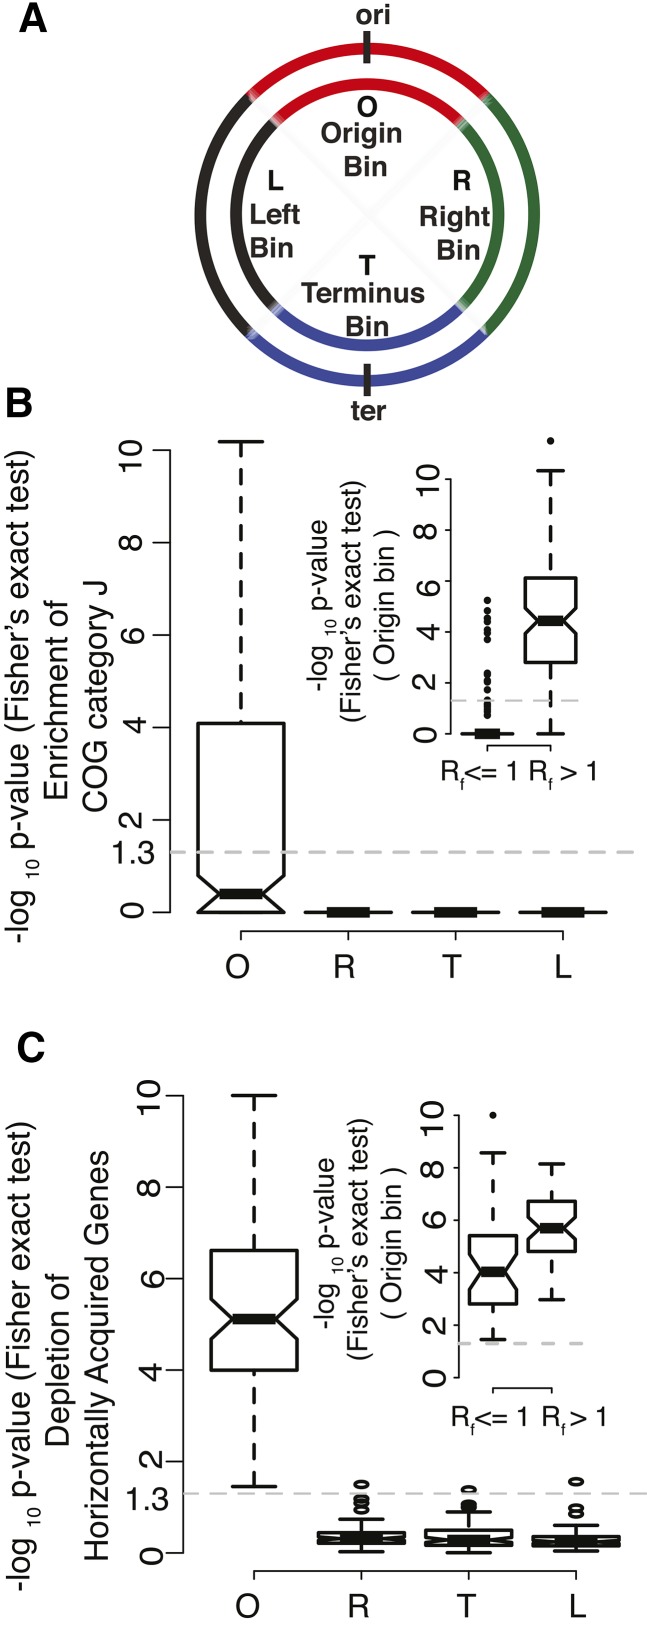
Chromosomal bin-based conservation of function. (A) Schematic representing equal sized bacterial chromosomal segments. Red: Origin bin (O); green: Right bin (R); blue: Terminus bin (T); black: Left bin (L). (B) Boxplot showing the enrichment of translation and ribosome biogenesis genes (COG category J) in O, R, T, and L chromosomal bins. (The dashed gray line at y = 1.3 corresponds to a P-value of 0.05. Values ≥1.3 are statistically significant.). Inner panel shows the enrichment of COG J in the O bin of fast-growing bacteria (Rf > 1). (C) Boxplot showing the depletion of horizontally acquired genes in different chromosomal bins. Inner panel showing the depletion of horizontally acquired genes in the O bin of both slow- (Rf ≤ 1) and fast (Rf > 1) growing bacteria.